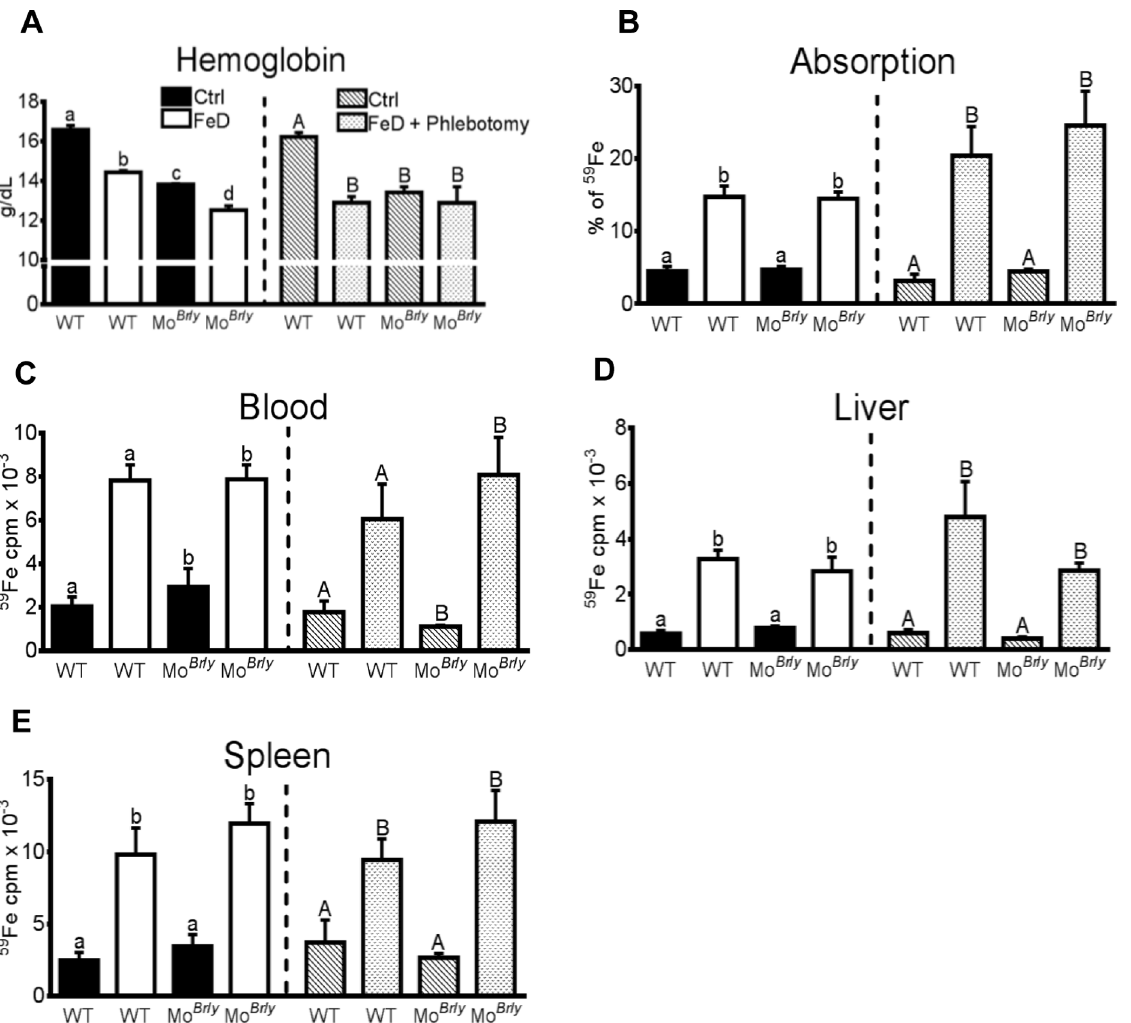
Figure 6. Intestinal iron absorption and whole-body iron utilization in experimental mice deprived of dietary iron with or without concurrent phlebotomy. Mice were fed a control diet or an iron-deficient diet for three weeks with or without concurrent once weekly bloodletting. Subsequently, 59 Fe was administered by oral gavage and the distribution of radioactivity was assessed 24 hours later. Blood hemoglobin levels are depicted ( A ) as well as % of 59 Fe dose absorbed ( B ), as an indicator of intestinal iron absorption, and radioactive counts in blood, liver and spleen ( C–E ). In all panels, the left side depicts data from dietary iron deprivation only, while the right panel shows data from dietary iron deprivation plus bleeding. Each bar is defined in panel A, and is consistent throughout all panels. a, b and A, B indicate statistical significance between groups within each one half of an individual panel ( p , 0.05). Genotypes are indicated below each bar. For dietary treatment groups, n=3 for all; for dietary treatment plus phlebotomy groups, n=5 for WT mice fed the control diet, n=6 for WT mice consuming the low-iron diet, and n=4 for Mo Br / y mice consuming both diets. Bars (A–E) depict mean 6 SD.